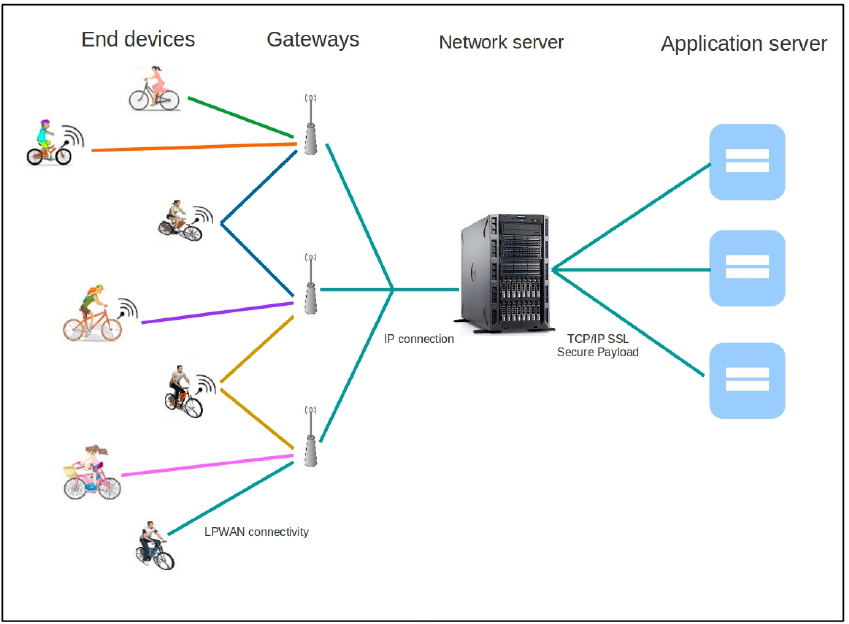
Figure 18. Illustration of IoB